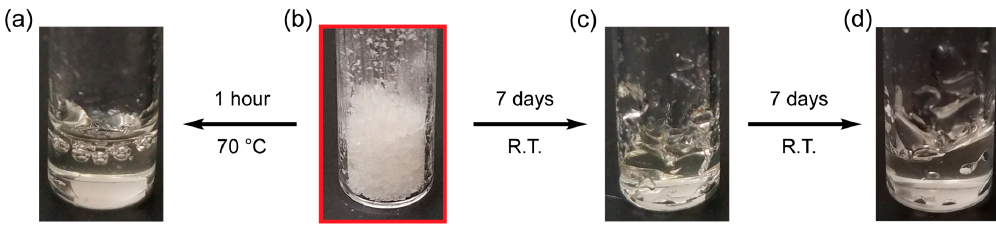
Figure 6. Photographs of solid PY-PSBTh broken xerogel ( b ) and reconstituted PY-PSBTh after standing at room temperature for 1 week ( c ), 2 weeks ( d ), and heating at 70 °C for 1 h ( a ).